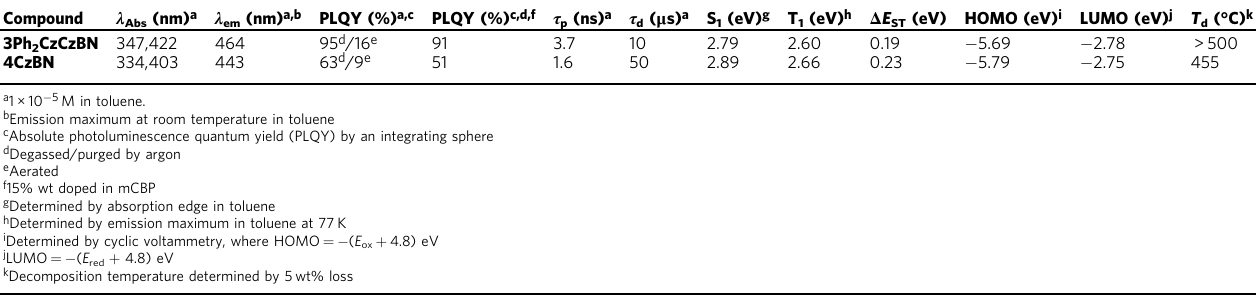
k RISC vs. 1/ T based on